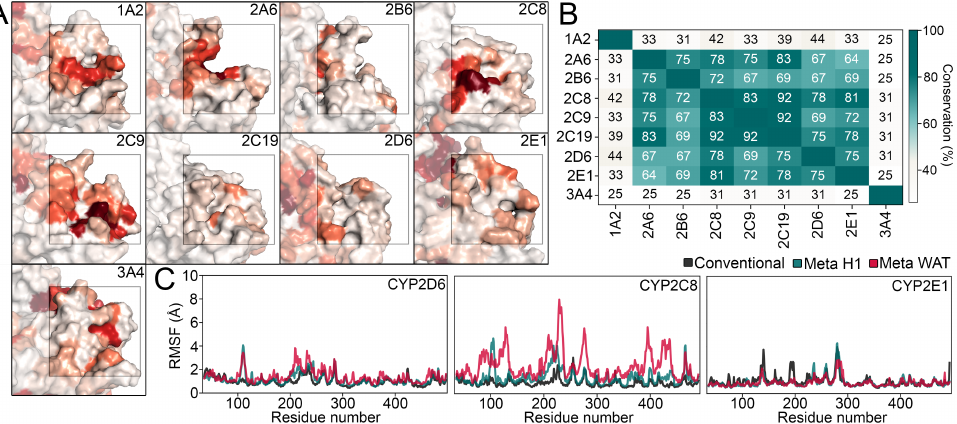
Figure 2. ( A ) Small-molecule binding hotspots on the surface of the nine enzymes studied in this work. Different shades of red indicate the degree of ligand association per residues as described in the Materials and Methods section. ( B ) Heatmap depicting the conservation of the H1 site within the panel of CYPs. ( C ) Analysis of structural changes observed in metdynamics